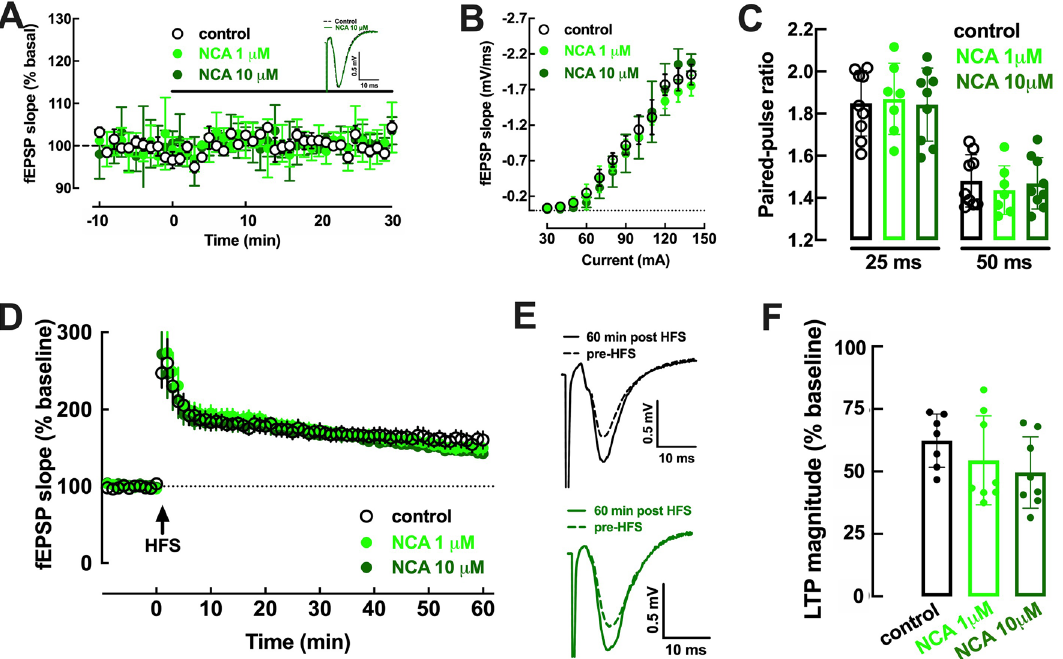
Figure 2. The neochlorogenic acid 5-O-(trans-3,4-dihydroxycinnamoyl)-D-quinic acid (NCA, 1 or 10 µM) did not affect either basal synaptic transmission or synaptic plasticity. NCA (1 µM, light green symbols or 10 µM, dark green symbols) did not alter basal synaptic transmission ( A ), measured as the descending slope of field excitatory postsynaptic potentials (fEPSP) recorded extracellularly in the stratum radiatum of the CA1 area upon stimulation of the afferent Schaffer collaterals, illustrated as inserts in panel A. Likewise, NCA (1 or 10 µM) did not modify the input–output responses ( B ) or the paired-pulse facilitation ratio, i.e. the ratio of the fEPSP slopes evoked by two consecutive pulses (ratio of P2/P1) with inter-pulse intervals of 25 or 50 ms ( C ). The average time course experiments of LTP induction ( D ), i.e. the variation of fEPSP slope over time upon induction of LTP with a high-frequency stimulation train (HFS: one train of 100 pulses delivered at 100 Hz) in hippocampal slices untreated (control, black symbols) or treated with NCA (1 or 10 µM), revealed that LTP magnitude was not affected by NCA ( F ). ( E ) Representative fEPSP recorded in ACSF (control conditions, upper row) and in the presence of 10 µM NCA (lower row) before (dashed traces) and 60 min after the HFS (filled traces). Data are mean ± S.E.M. of 4–8